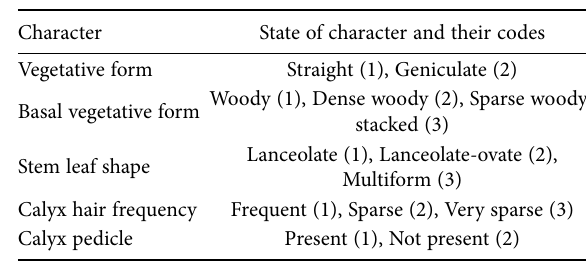
Table 2. Qualitative morphological characters studied in Z. clinopo- dioides populations.